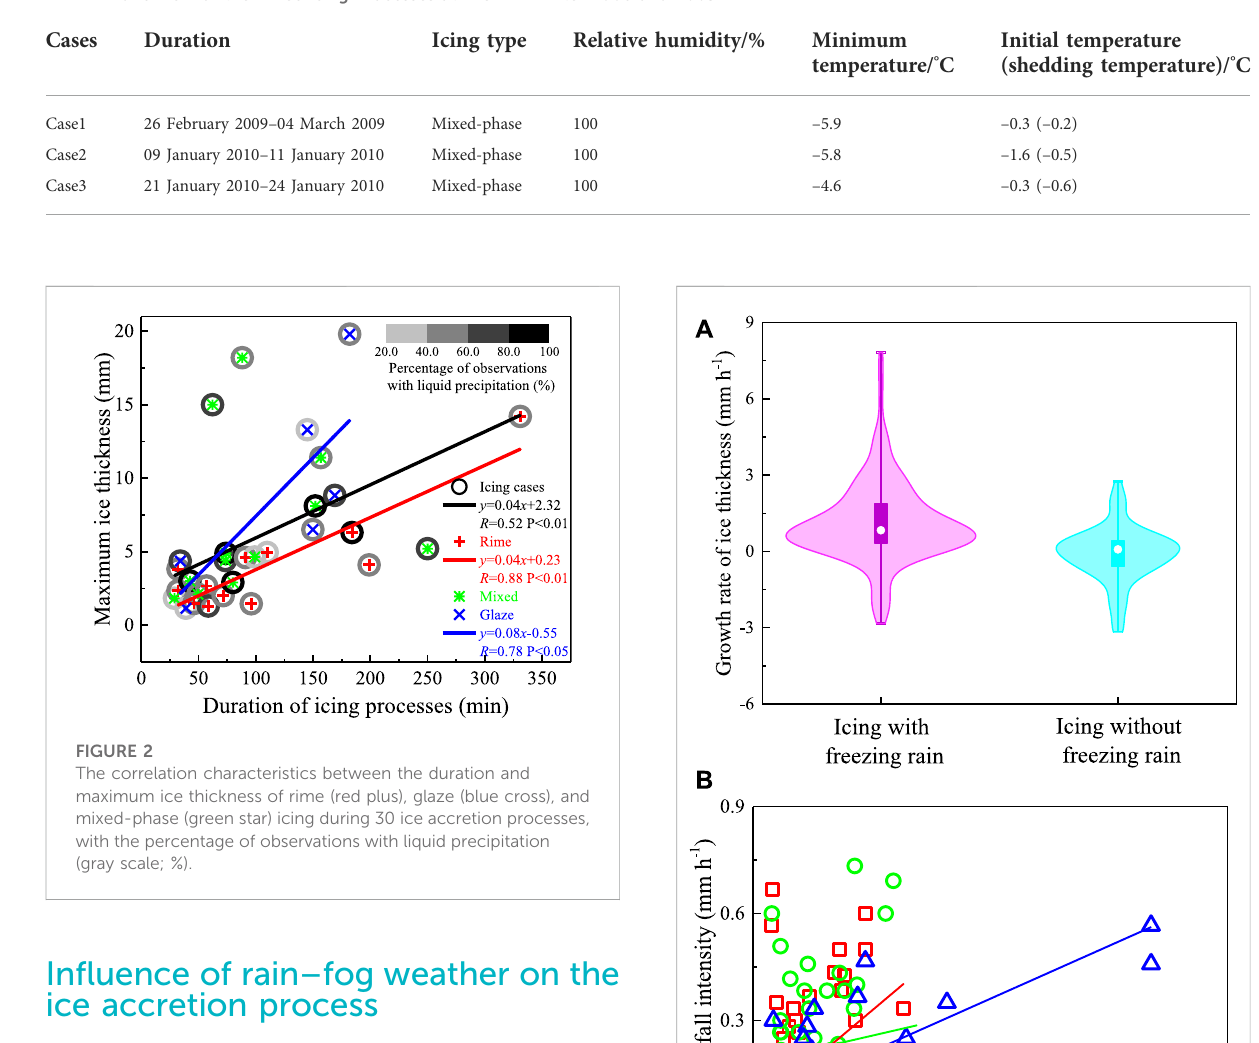
TABLE 1 Overview of the Three Icing Processes at Enshi in winter 2008 and 2009.